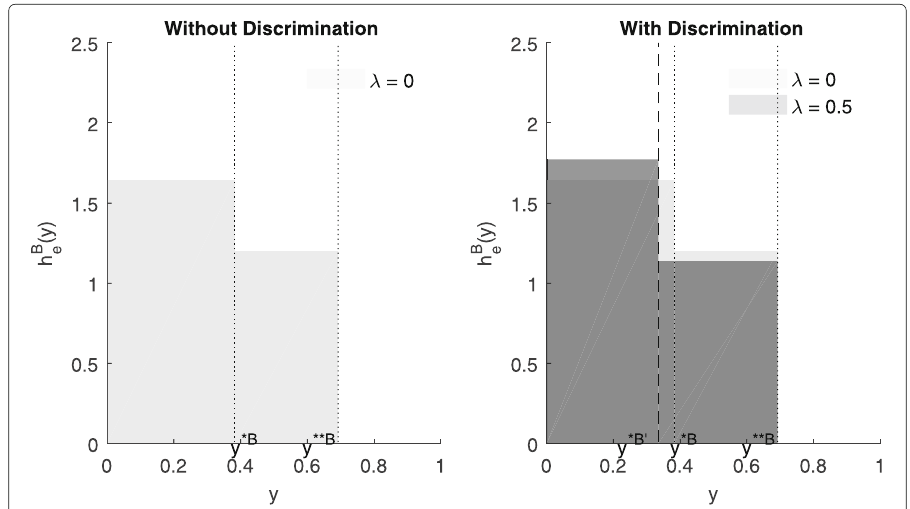
Fig. 4 Wage sector ability PDF with and without